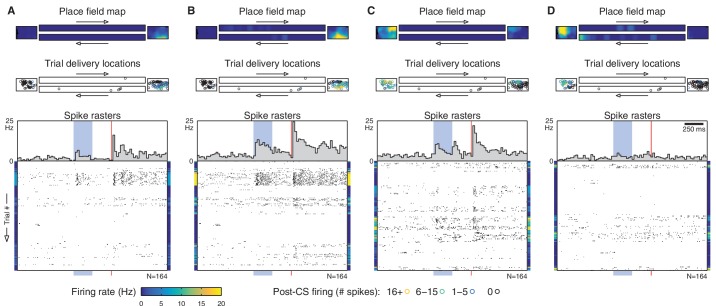
Additional simultaneously-recorded cells.The example cell from Figures 1E and 2B is shown in panel (B). The other panels of this figure show simultaneously recorded cells from different tetrodes. As in Figure 2B, each panel contains a place field map, trial delivery locations (color-coded by CS-evoked firing), and spike rasters for a single cell. Rasters are shown in chronological order (as in Figure 1E), so the same row in each panel corresponds to the same trial. Note that different sets of cells fire as the animal moves around, and cells with disjoint place fields fire on different subsets of trials. The colored bars flanking each raster show the cell’s place field intensity for each trial.